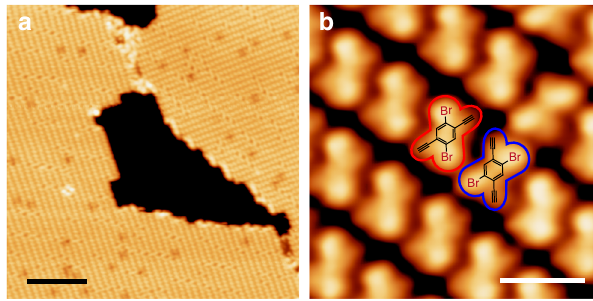
Fig. 1 Reactions of 2Br-DEB. Possible reaction pathways and corresponding